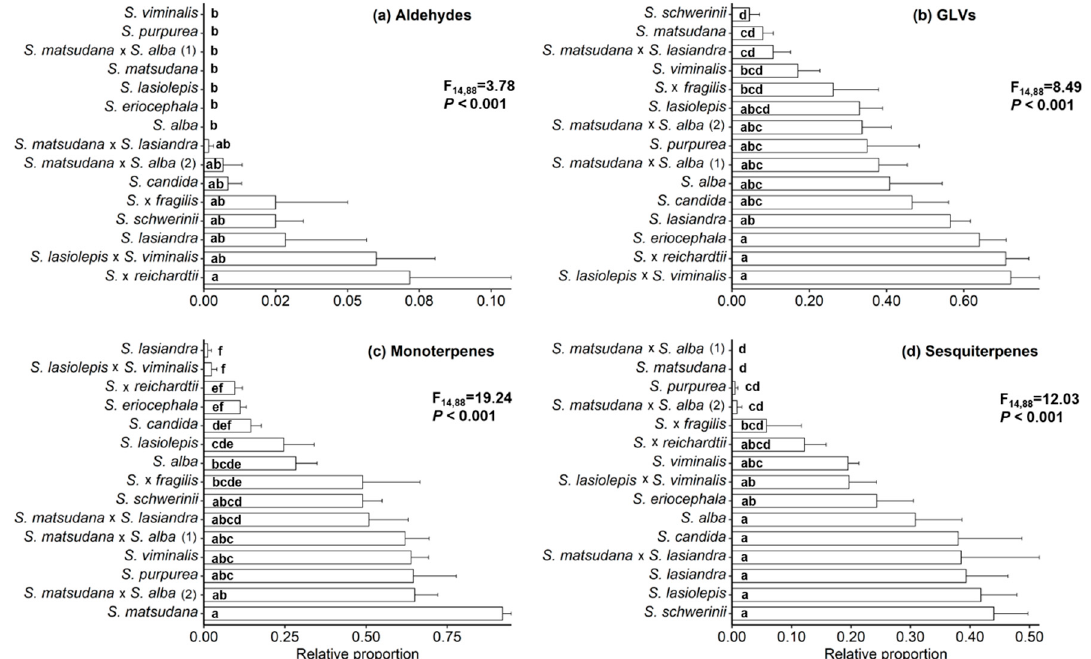
Figure 3. Relative proportions of each major VOC class: ( a ) aldehydes, ( b ) GLVs, ( c ) monoterpenes and ( d ) sesquiterpenes, emitted by the fifteen willow species and hybrids. The values and error bars are means ± SE. Different letters represent statistically significant differences ( α = 0.05) after post-hoc comparisons using Tukey’s HSD test.